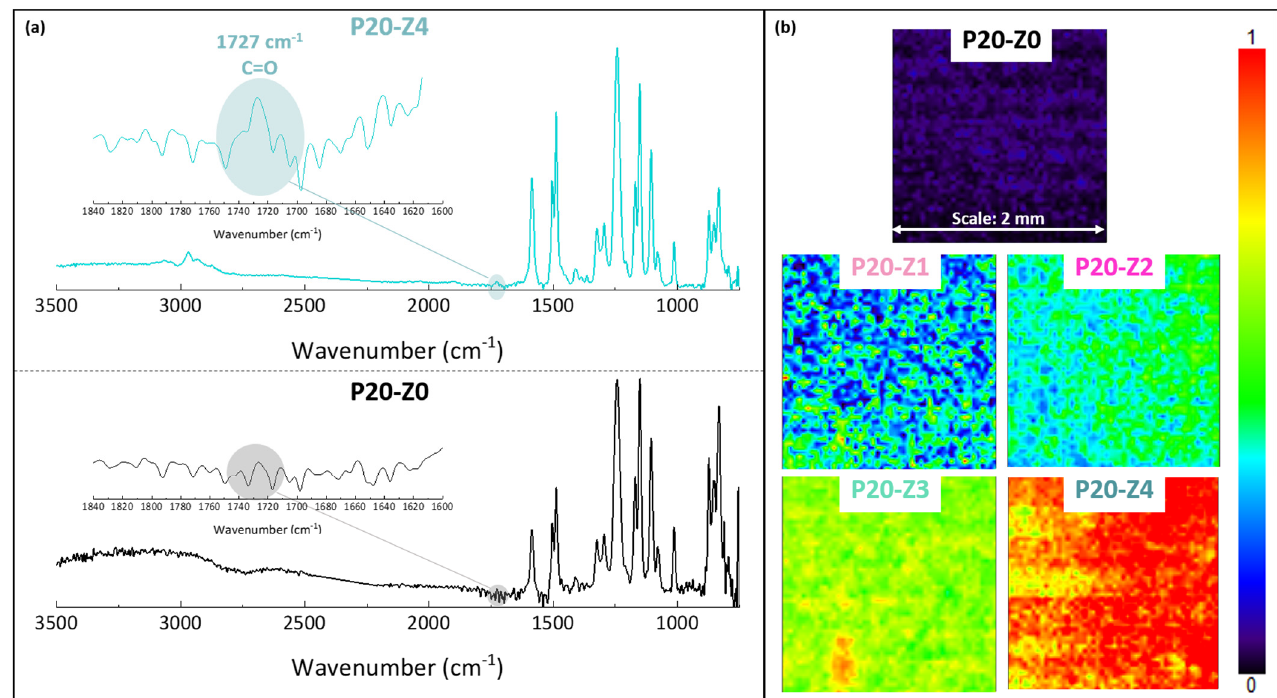
Figure 6. Chemical characterization of membranes by FT-IR ( a ) ATR-FTIR characteristic spectra of virgin (P20-Z0) and zwitterionic (P20-Z4) membranes. ( b ) Mapping FT-IR analysis of the different membranes, performed at 1727 cm − 1 (C=O).